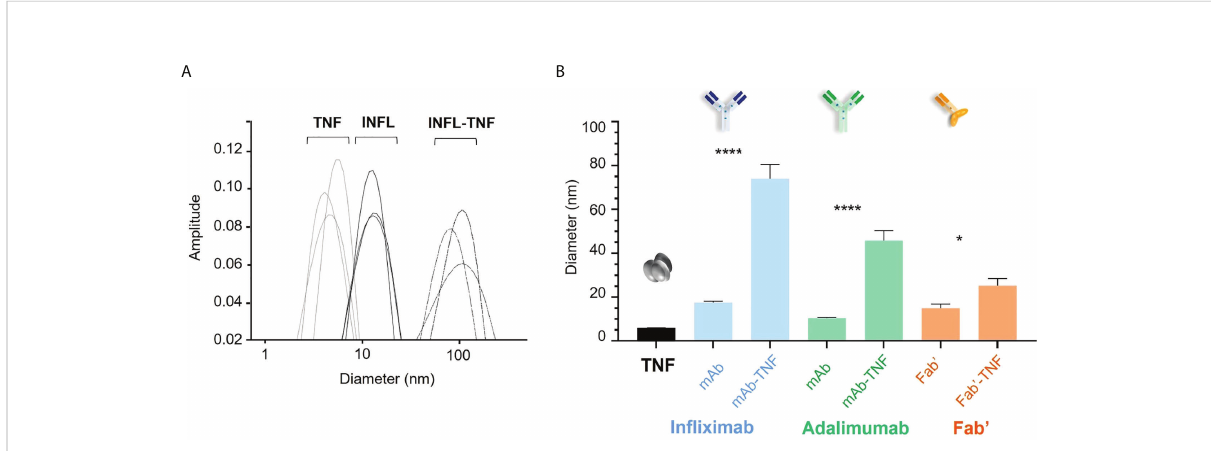
FIGURE 2 Size characterization of TNF antagonists and immune complexes of TNF with antagonists by dynamic light scattering (DLS). (A) Representative hydrodynamic diameter pro fi le of TNF, INFL and INFL-TNF as measured by DLS. Each line denotes one of three technical replicates for each condition, which were then ran in fourteen independent experiments, i.e., one for each donor. (B) Size comparison of TNF (black), TNF antagonists and their complexes with TNF; INFL and INFL-TNF (blue), ADAL and ADAL-TNF (green) and Fab ’ and Fab'-TNF (orange), where each bar correspond to the mean and the standard error of mean (SEM) from fourteen independent experiments (n=14, ****p < 0.0001, *p <